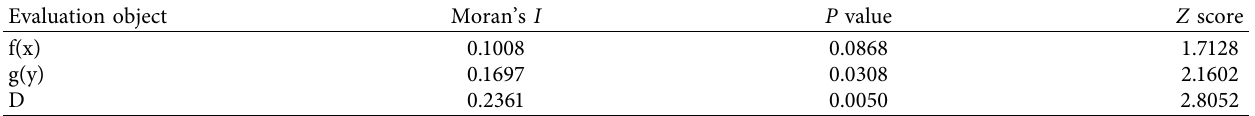
Table 4: Global Moran’s I index